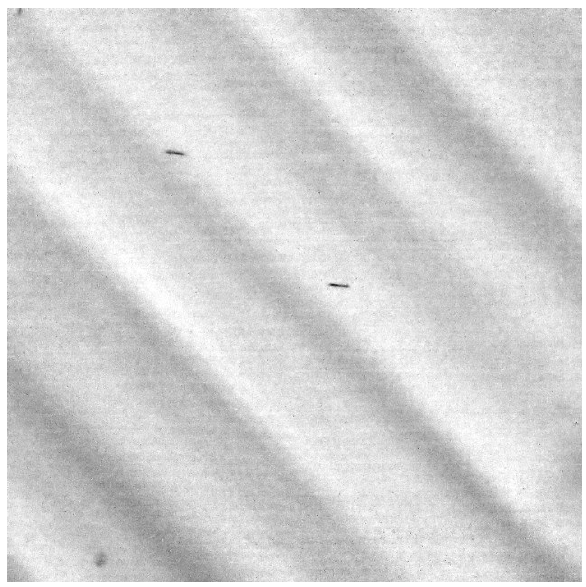
Fig. 4. A sample image from the high speed camera